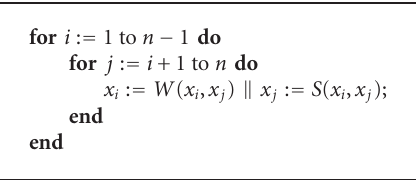
Algorithm 2: Nested loop algorithm for reduction